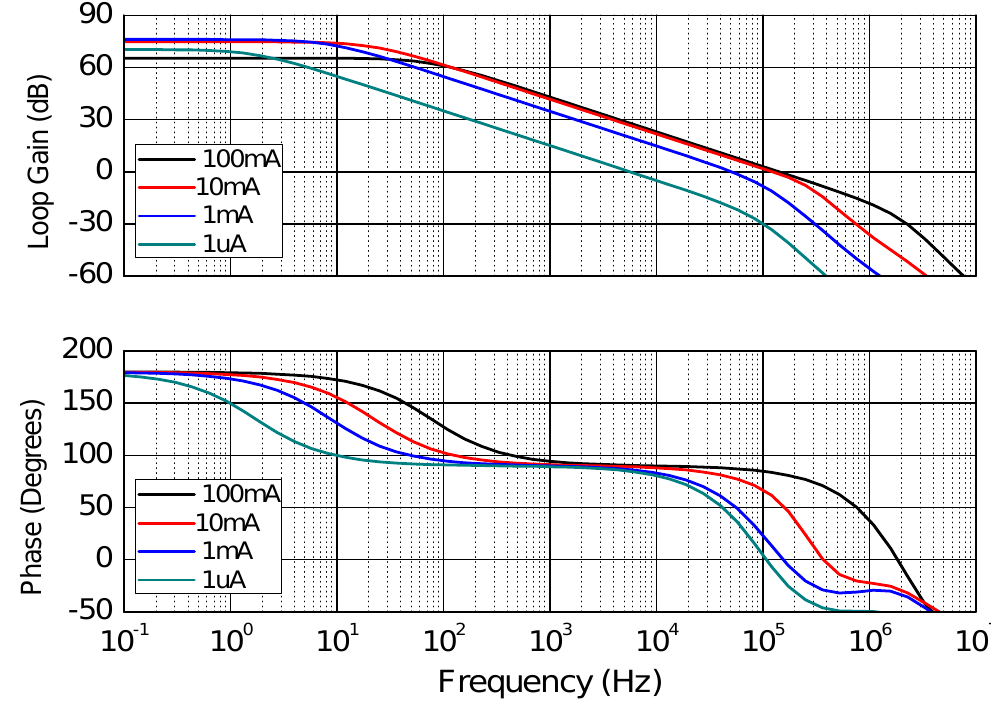
Figure 7. Loop gain frequency response of the proposed high-voltage (HV)